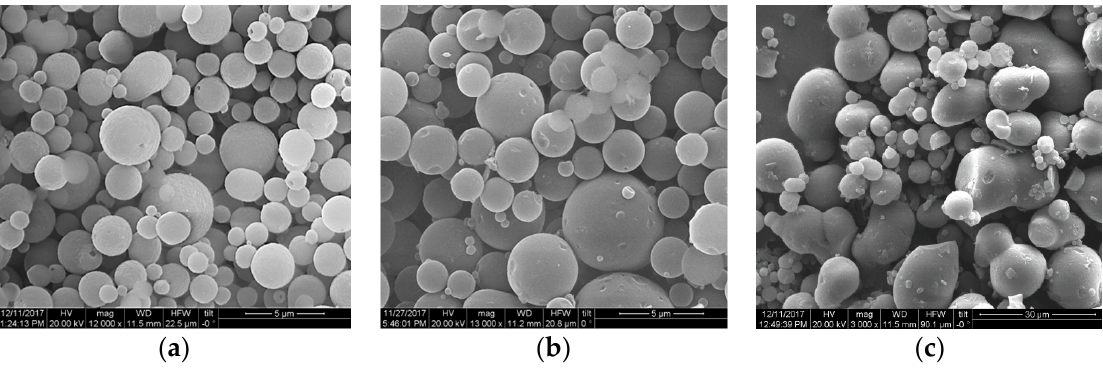
Figure 2. Morphology of lignin after HOS-SE pretreatment with increasing ethanol content of ( a ) 50% v/v ; ( b ) 60% v/v ; ( c ) 70% v/v .